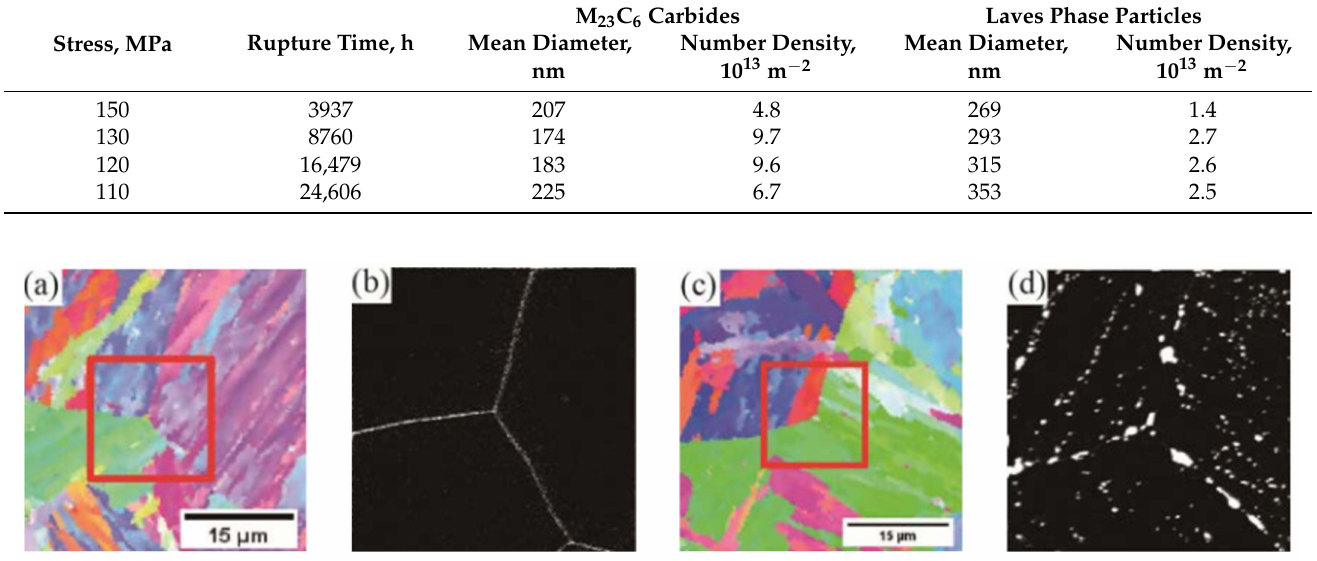
Figure 10. Inverse pole figure maps by EBSD and distribution of B by Nano-SIMS of MARBN steel with 139 ppm B: ( a , b ) after normalization from 1100 ◦ C, and ( c , d ) after creep test at 650 ◦ C for 15,426 h. Reprinted with permission from Ref. [68]. Copyright 2019 ASM International.